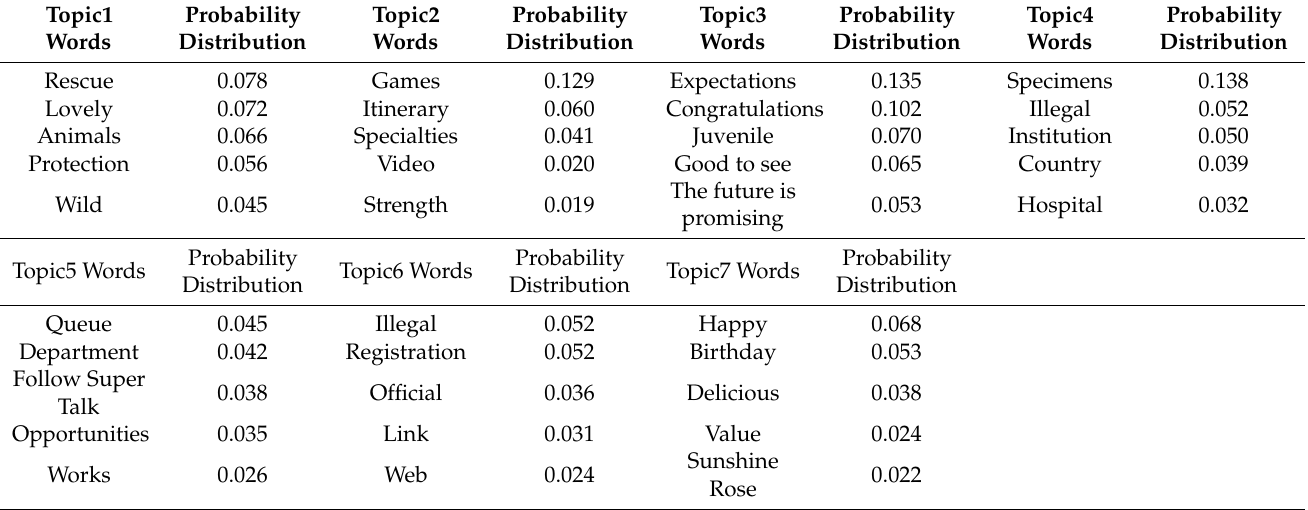
Table 11. A3 LDA theme model